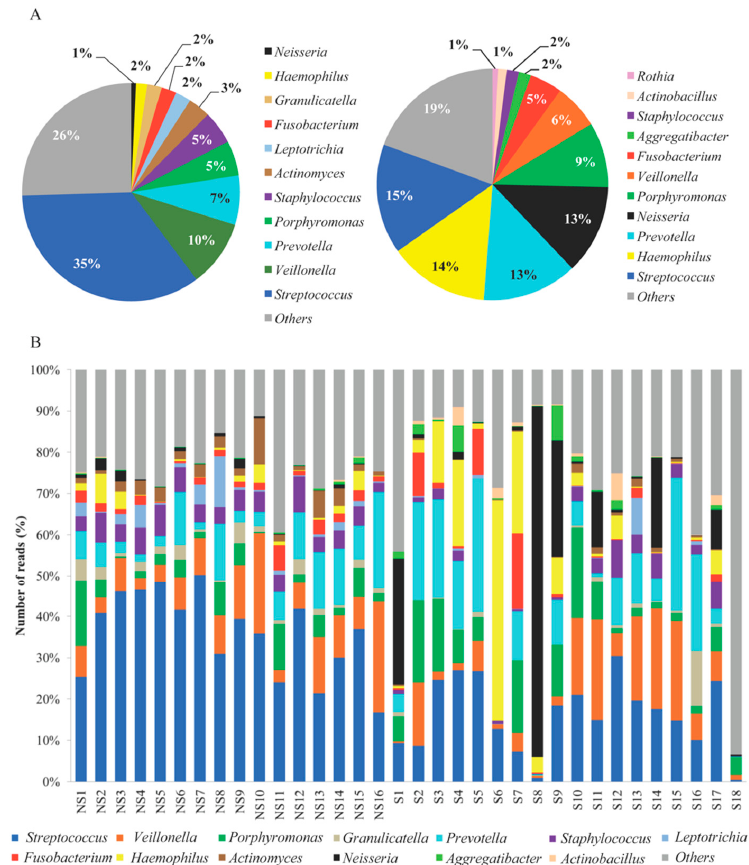
Figure 3. Composition of the major genera observed in nonsmoker (NS; n = 16) and smoker (S; n = 18) saliva samples. ( A ) comparison of the taxonomic analyses at the genus level by group. ( B ) composition of the major genera by study participant. The bacterial abundance was established by the analysis of the 16S rRNA gene using a Quantitative Insights into Microbial Ecology (QIIME)